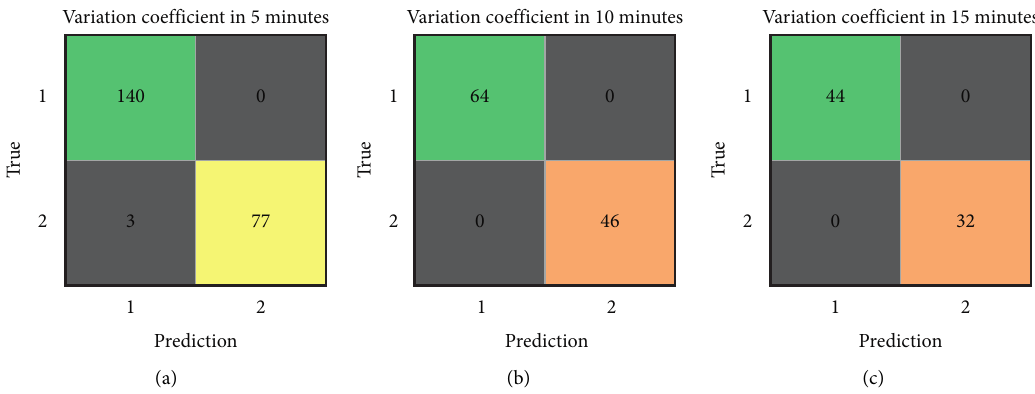
Figure 5: Illustration of the confusion matrix of the variation coefficient in different periods.